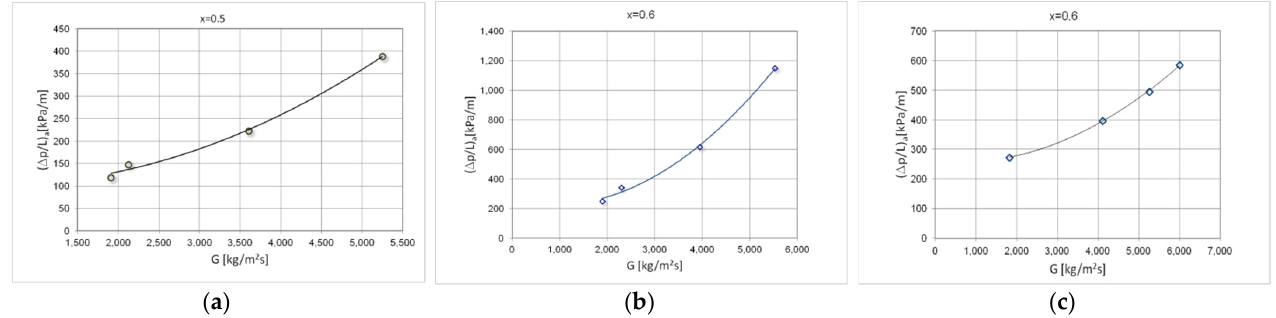
Figure 8. Experimental average flow characteristics of the pressure drop ( Δ p/L) a depending on the mass flow density G during the condensation in a mini-channel with a hydraulic diameter d h = 0.5 mm (T s ≈ 50 ◦ C), refrigerants: ( a ) HFE7100; ( b ) Novec649; ( c ) HFE7000.